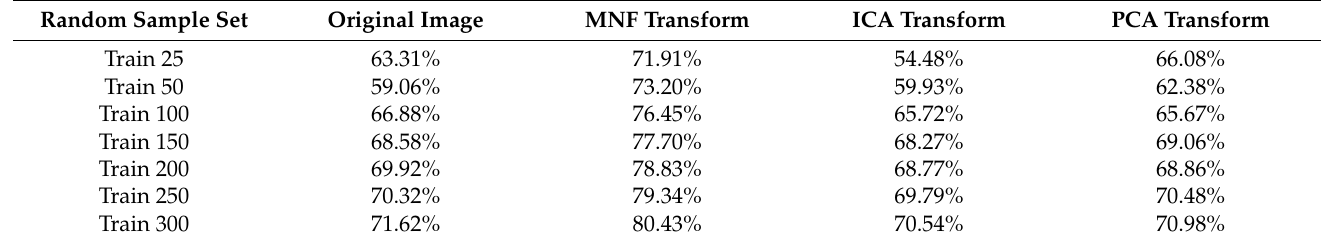
Table 2. RF classification accuracy evaluation of random sample sets in the Honghu